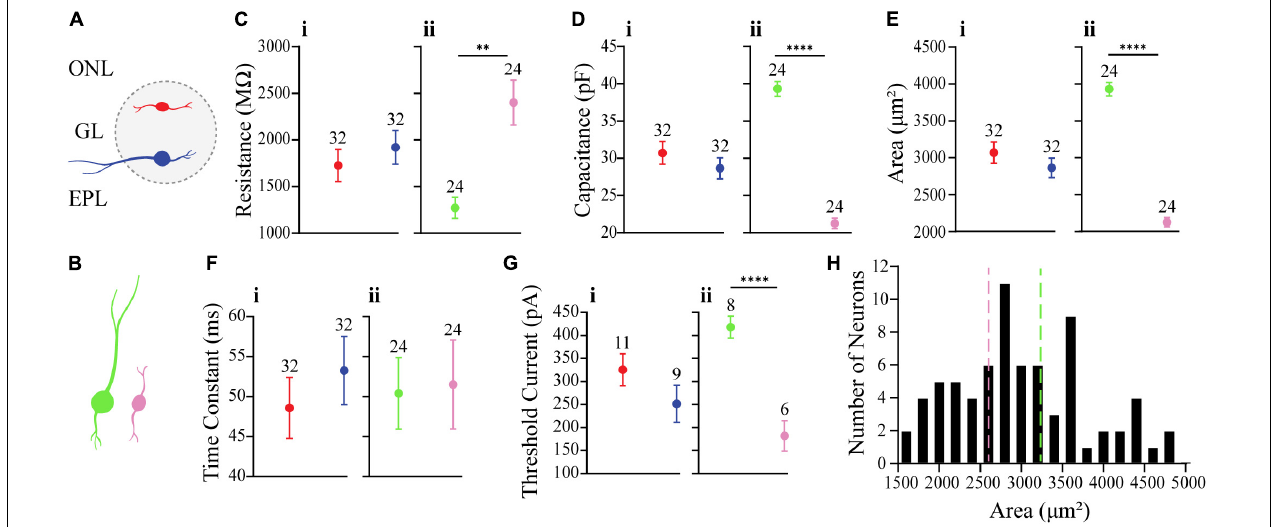
FIGURE 2 | Comparison of membrane properties between OB DA neurons based on their localization in the GL and neuronal area. (A) Top, red neurons = closer to ONL; Bottom, blue neurons = closer to the EPL. (B) Large, green neurons = 3390 to 4890 µ m 2 ; Small, pink neurons = 1589 to 2610 µ m 2 . All data represented as mean ± SEM. (C) For membrane resistances (in M (cid:127) ), there was no significant difference ( n = 64, p = 0.4181, Ci ) between neurons based on their glomerular localization, but there was a significant difference ( n = 48, p = 0.0001**, Cii ) based on neuronal area. (D) For membrane capacitance (in pF), there was no significant difference ( n = 64, p = 0.2979, Di ) between neurons based on their glomerular localization, but there was a significant difference ( n = 48, p < 0.0001****, Dii ) based on neuronal area. (E) For neuronal areas (in µ m 2 ), like capacitance, there was no significant difference ( n = 64, p = 0.2979, Ei ) based on glomerular localization. (F) For time constants (in ms), there was no significant difference ( n = 64, p = 0.4153, Fi ) between neurons based on their glomerular localization, and no significant difference ( n = 48, p = 0.8786, Fii ) between neurons based on neuronal area. (G) For action potential thresholds (in pA), there was no significant difference ( n = 20, p = 0.1792, Gi ) between neurons based on their glomerular localization, but there was a significant difference ( n = 14, p < 0.0001****, Gii ) between neurons based on area. (H) Frequency distribution of neuronal areas of DA neurons (2996 ± 94.72 µ m 2 , n = 73). Pink and green dashed borders are used to distinguish Small and Large neurons, respectively. TABLE 1 | Membrane properties of recorded OB DA neurons based on glomerular localization. Top of glomerulus Bottom of glomerulus All neurons Membrane resistance (M (cid:127) ) 1725 ± 173 . 5 1926 ± 174 . 5 1742 ± 113 .